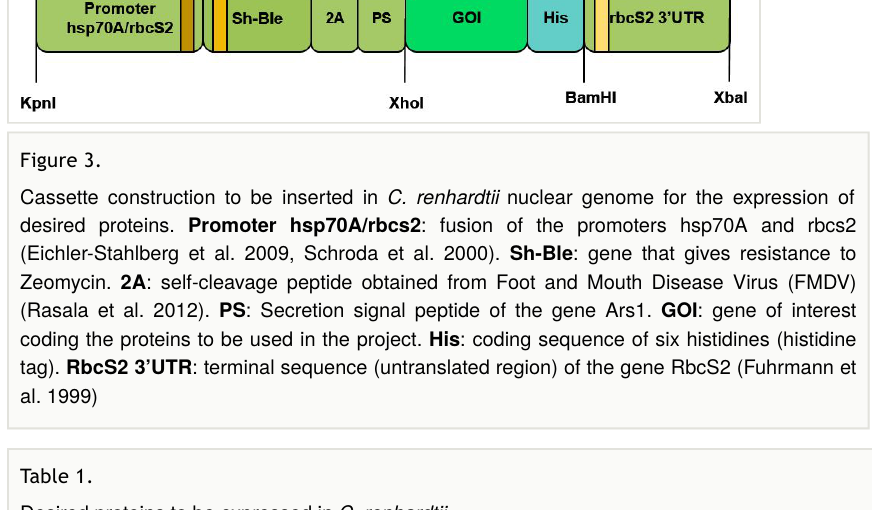
Desired proteins to be expressed in C. renhardtii